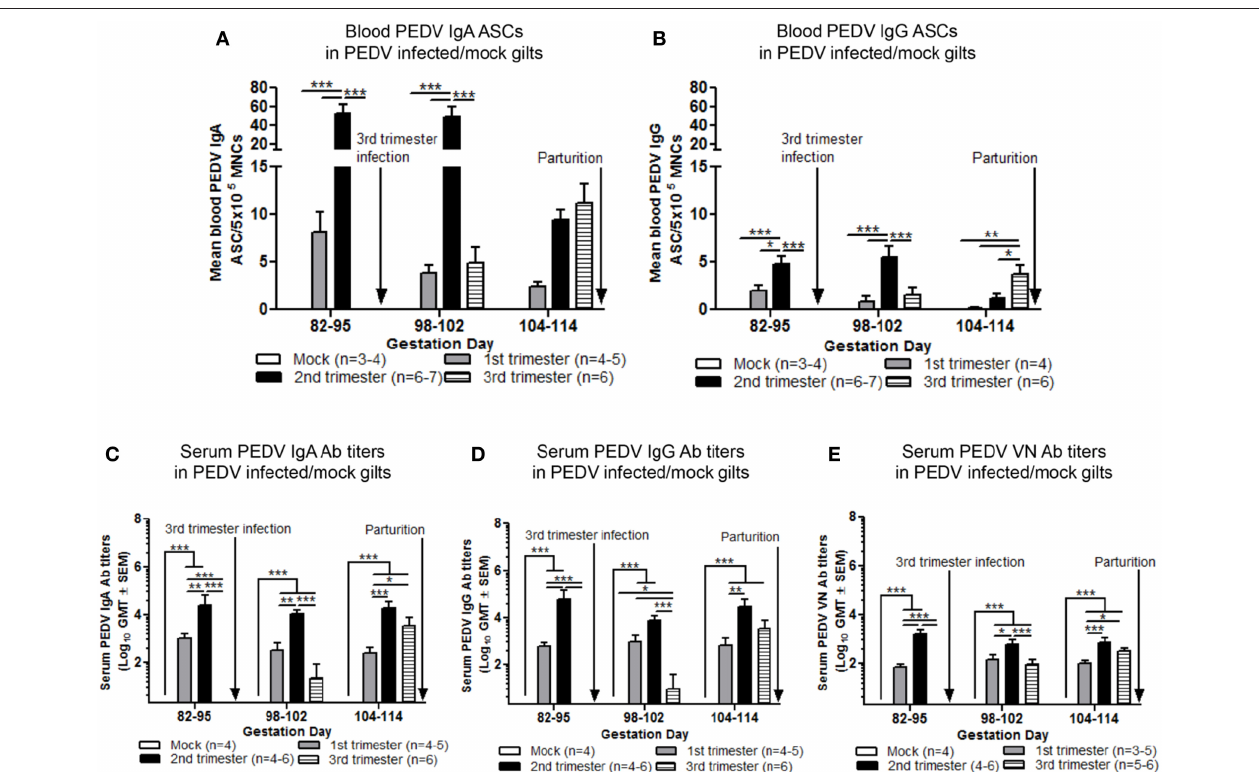
FIGURE 5 | Second trimester gilts maintained elevated circulating PEDV specific IgA and IgG antibody secreting cells (ASCs) and serum PEDV specific IgA, IgG and virus neutralizing (VN) antibodies (Abs) in late pregnancy. (A) Peripheral blood mononuclear cells (PBMCs) were isolated and added to PEDV ELISPOT plates to determine the PEDV specific IgA and (B) IgG ASCs. (C) Serum PEDV IgA and (D) IgG Abs were determined by ELISA while (E) serum PEDV VN Ab responses were determined by VN Ab assay. Gilts were sampled at gestation day (GD) 82–95, 98–102, and 104–114. Asterisks indicate significant differences among treatment groups at the same time point (mean ± SEM). Statistical analysis was performed using the two-way ANOVA with repeated measures and Bonferroni’s correction for multiple comparisons. * P < 0.05, ** P < 0.01, *** P <